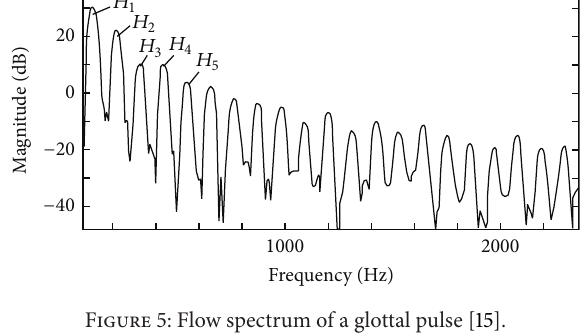
Figure 5: Flow spectrum of a glottal pulse [15].